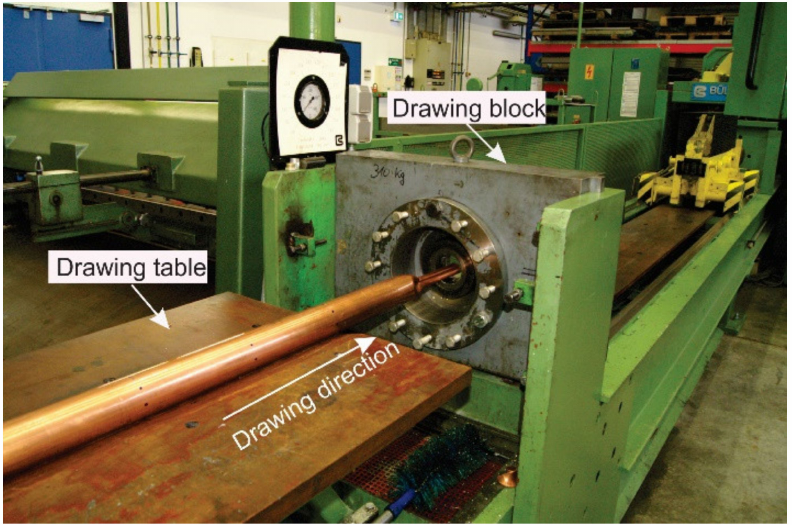
Figure 2. Tube drawing facility.